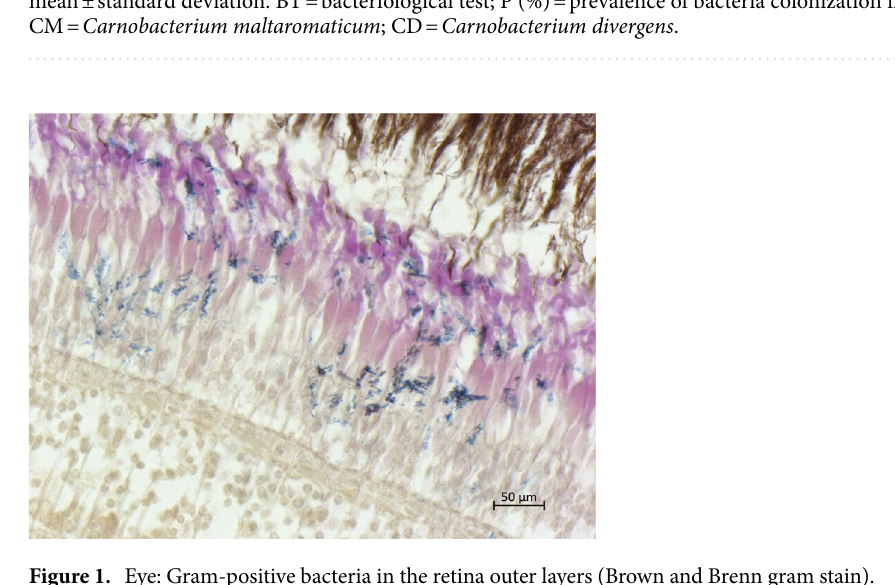
Figure 1. Eye: Gram-positive bacteria in the retina outer layers (Brown and Brenn gram